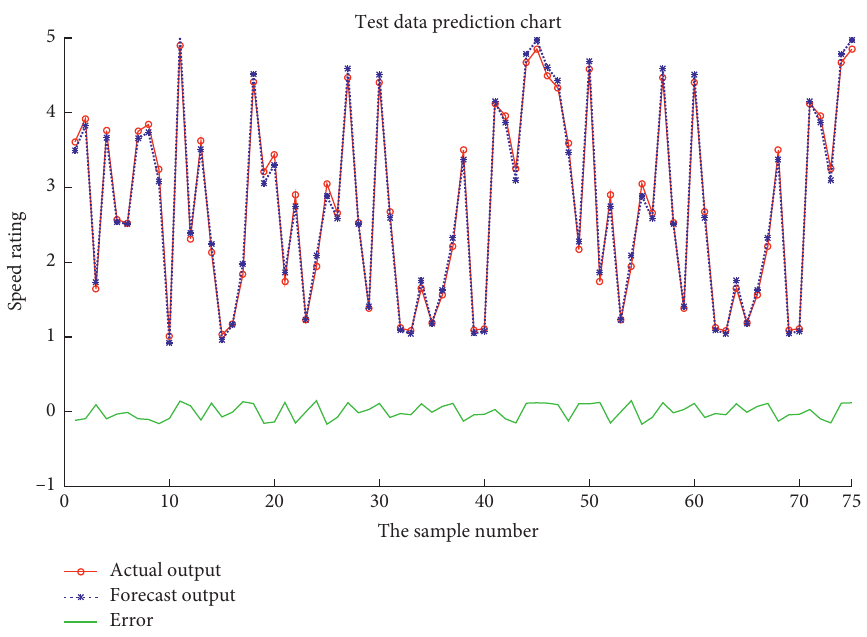
Figure 5: Traditional T-S fuzzy neural-network test data prediction chart.